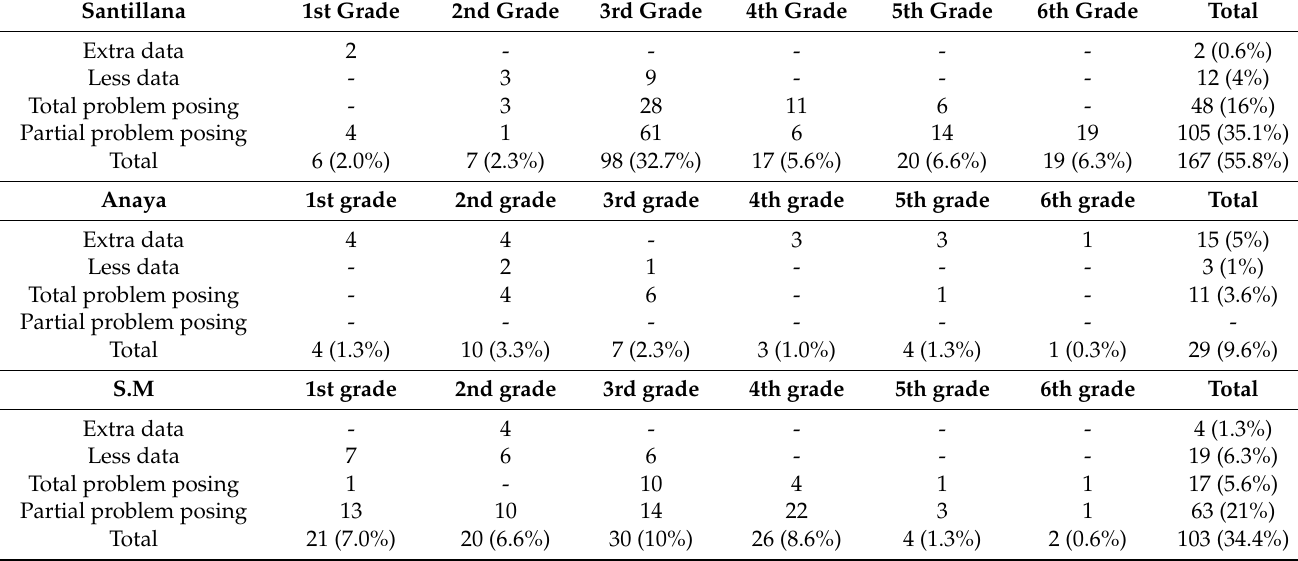
Table 7. Results of the frequency and variability of problems that present some type of challenge by educational level and